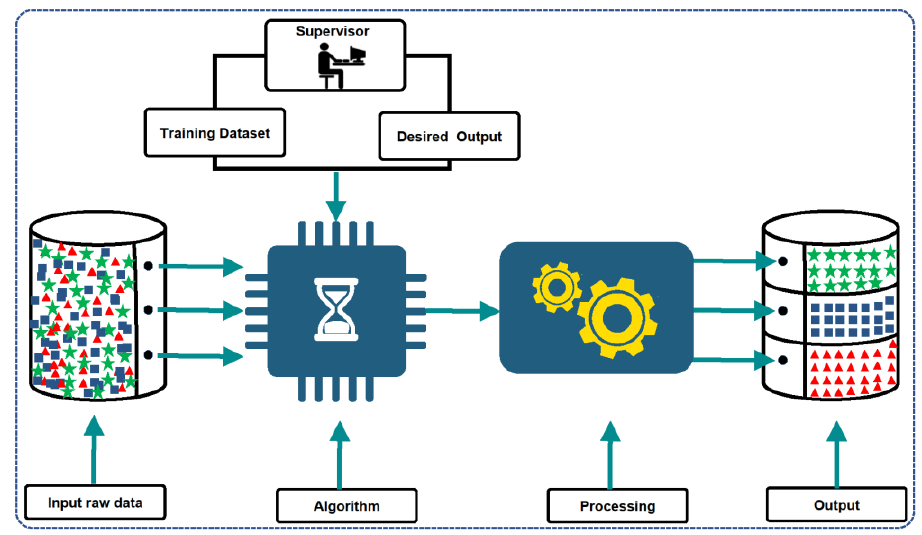
Figure 1. Supervised learning process.